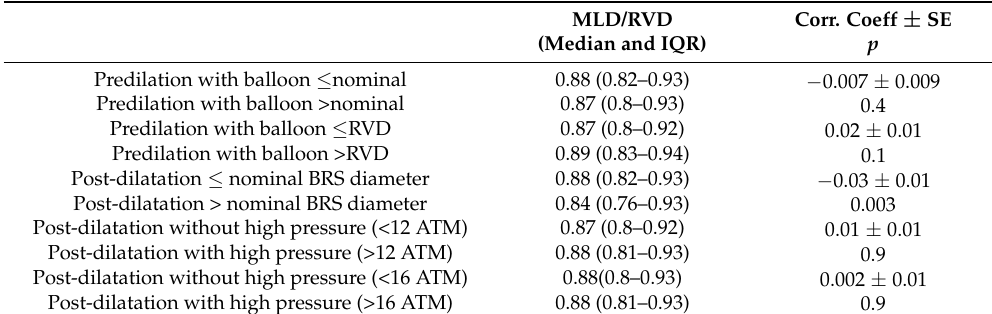
Table 3. Median (IQR) and correlation coefficient for evaluation of the impact of different procedural predictors with respect to the MLD/RVD